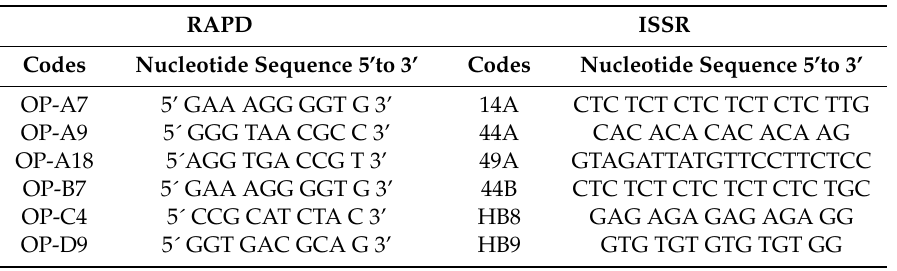
Table 5. Nucleotide sequences of RAPD and ISSR primers used for the study of the genetic diversity of Onopordum alexandrinum habitats. The primers were synthesized by Operon Biotechnologies Inc. (Cologne,